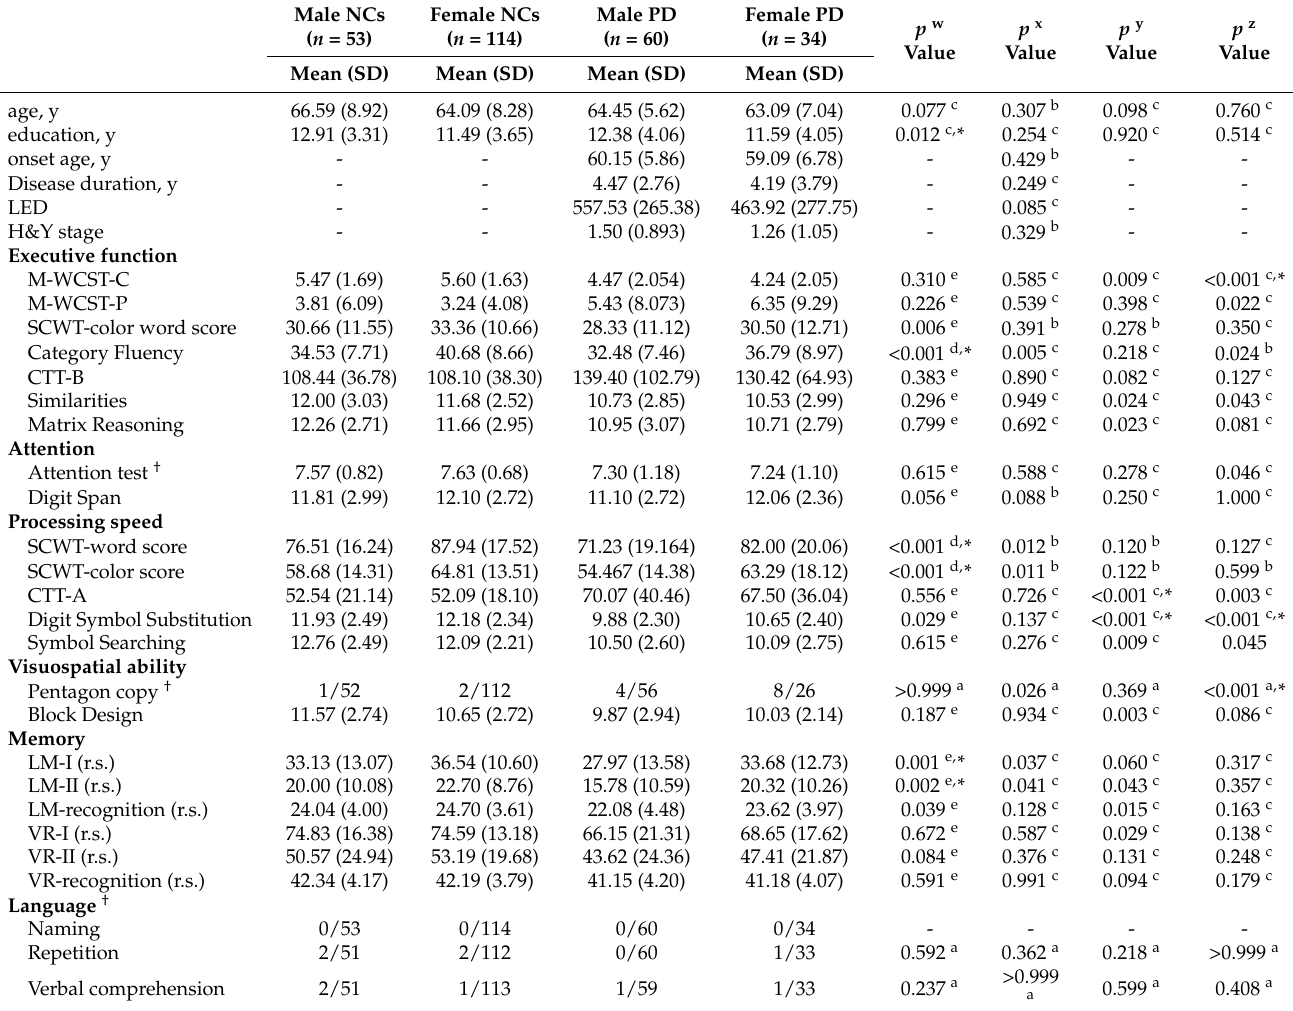
Table 3. Sex-stratified analysis of the neurocognitive tests in PD and